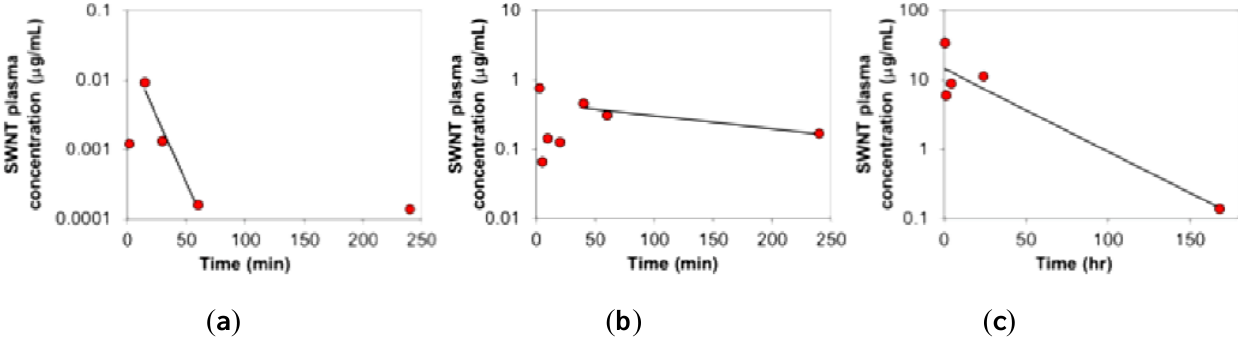
= 8–10 min; ( b ) siRNA/ l -PEG 1/2